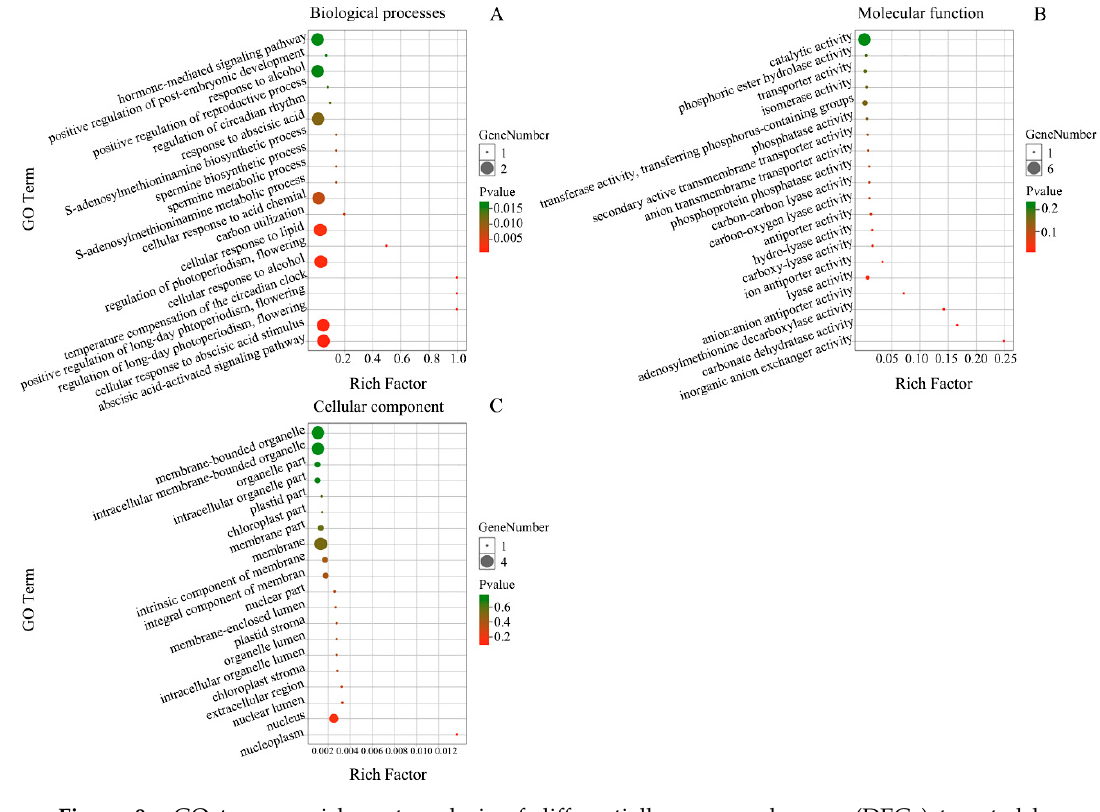
Figure 9. GO terms enrichment analysis of di ff erentially expressed genes (DEGs) targeted by di ff erentially expressed miRNAs (DEMs). ( A ) Biological process; ( B ) molecular function; ( C ) cellular component.